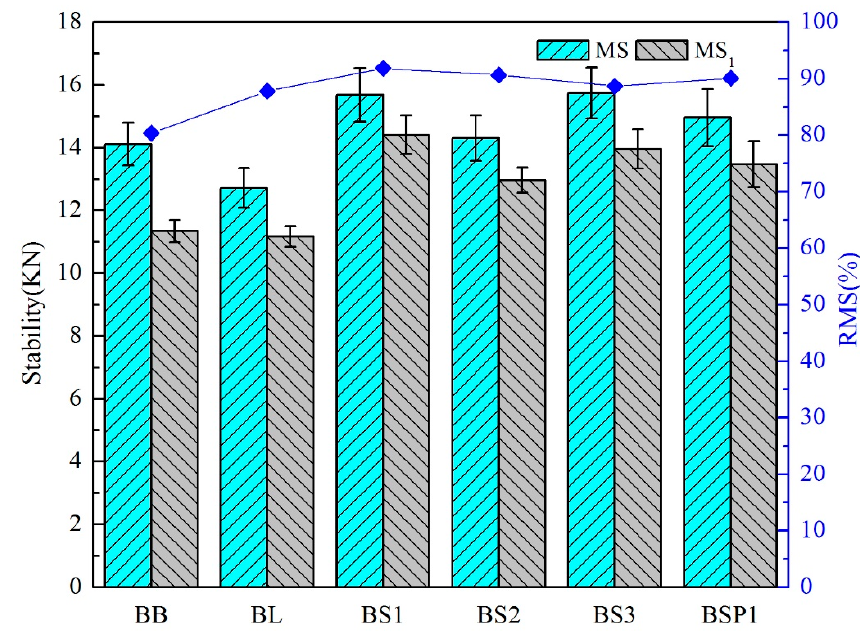
Figure 9. Marshall stability test results with different coarse aggregates.